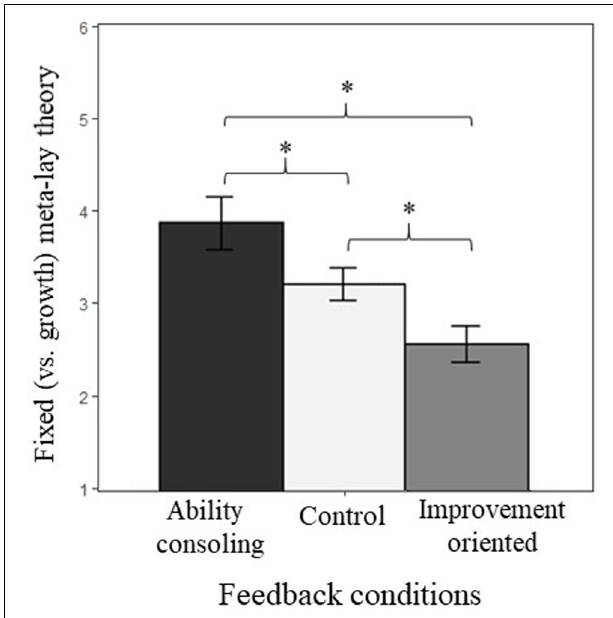
FIGURE 2 | Mean meta-perceptions of potential across the three conditions. Error bars represent 95% confidence